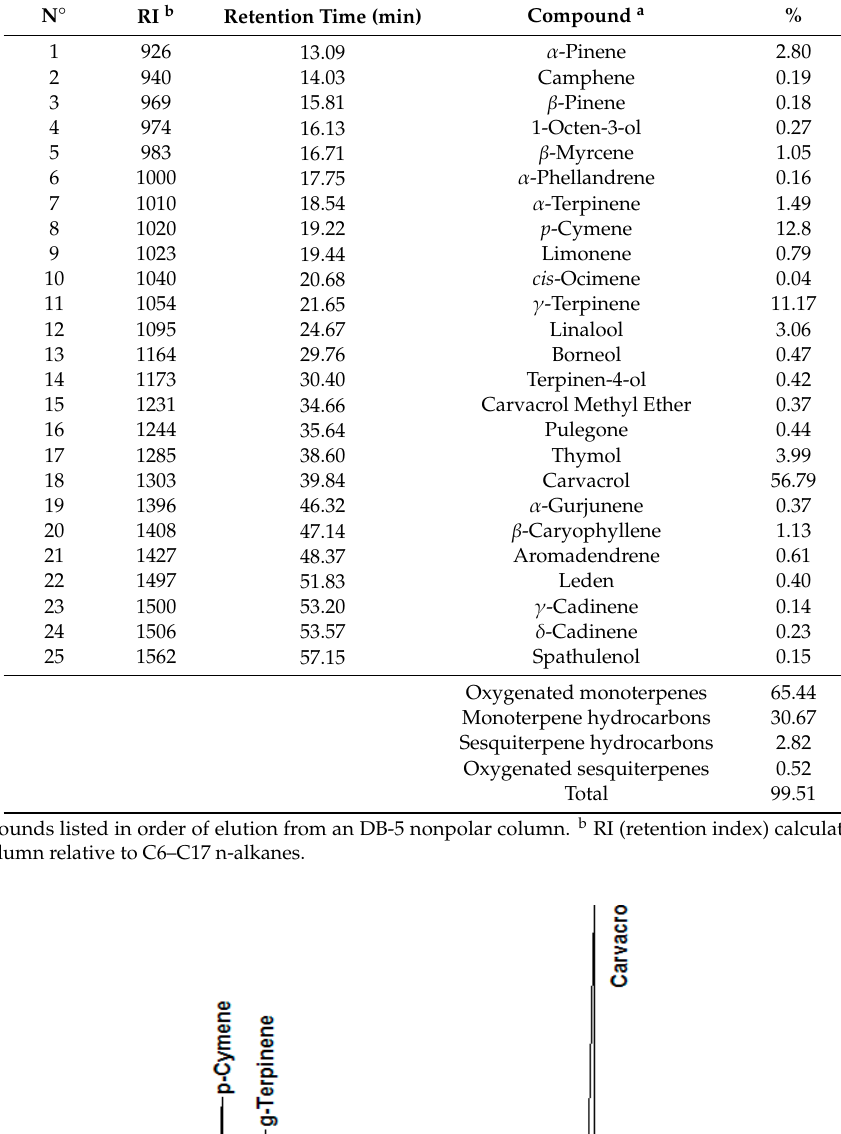
Table 1. Chemical profile of essential oil from thyme essential oil extracted by steam distillation and analyzed with gas chromatography.